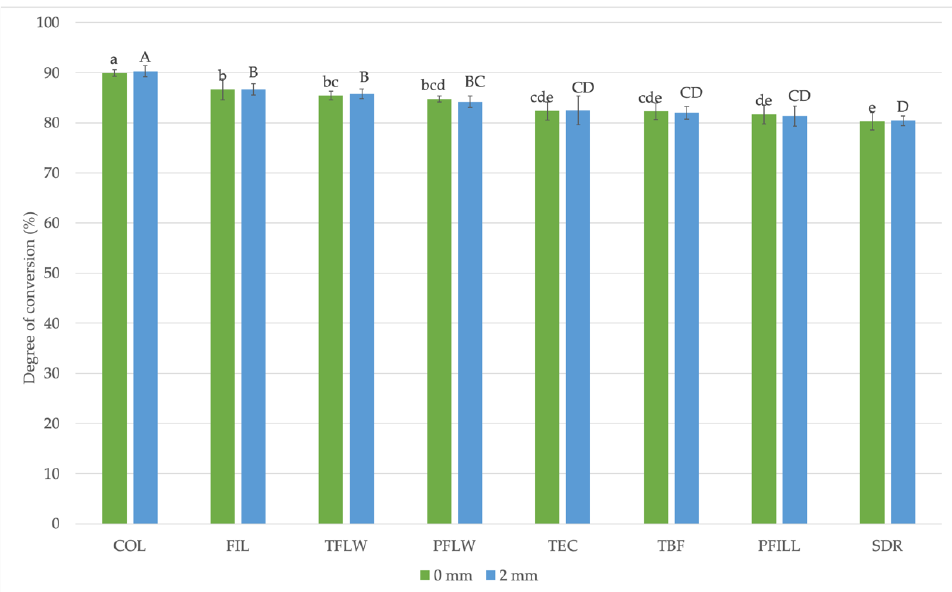
Figure 5. Comparison of the degree of conversion values (%) for tested materials. All pairs (0 mm vs. 2 mm) were statistically similar. Lowercase letters indicate statistically homogeneous groups at 0 mm, while uppercase letters indicate homogeneous groups at 2 mm ( p < 0.05).